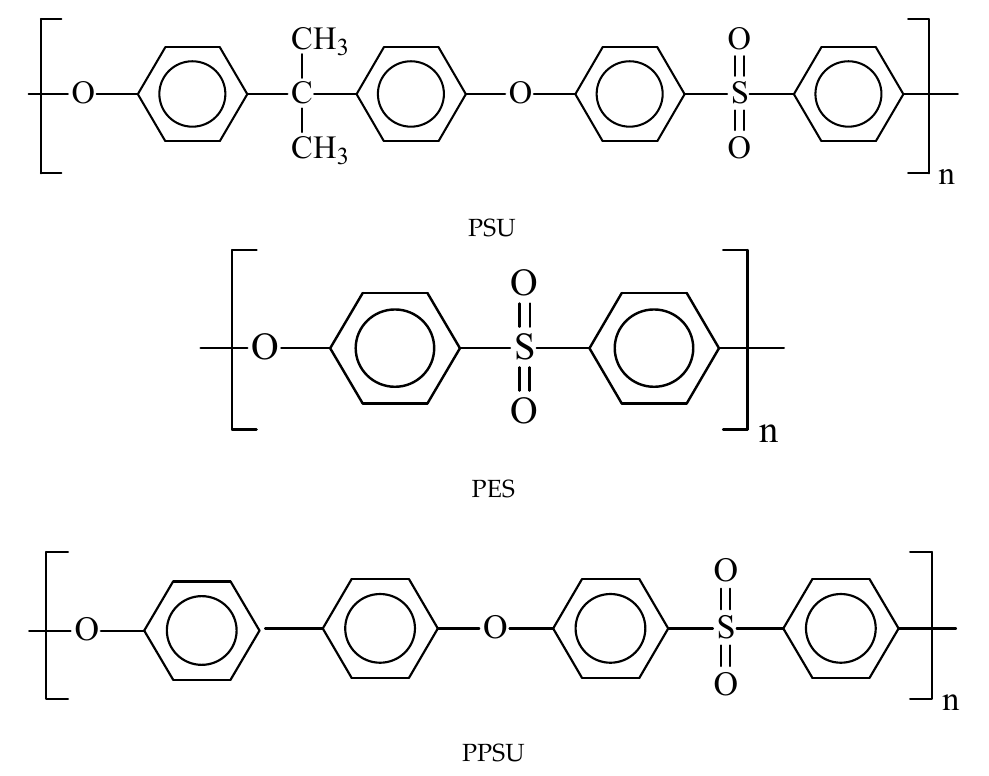
Scheme 1. Structural formulas of